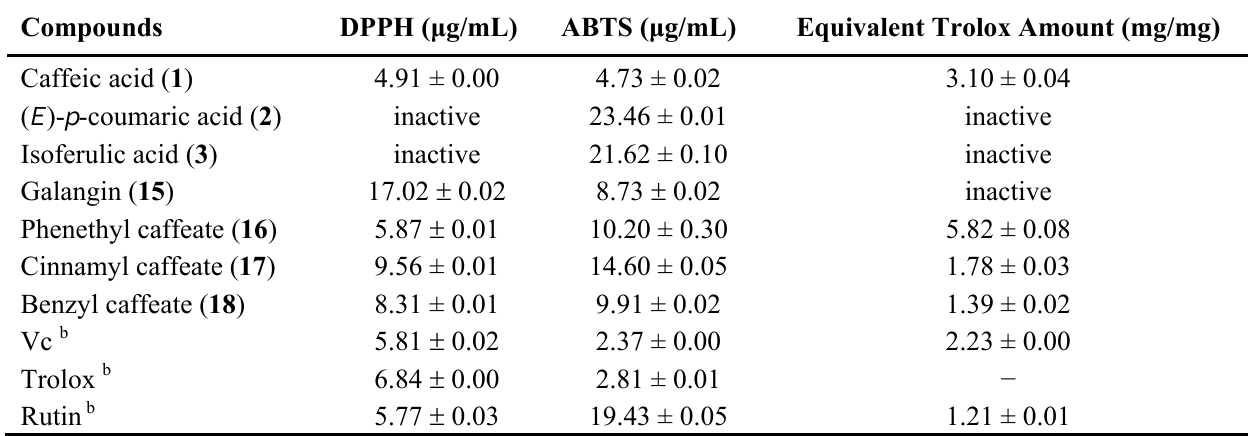
Table 2. The antioxidant activities of the selected compounds from propolis collected in Anhui, China.